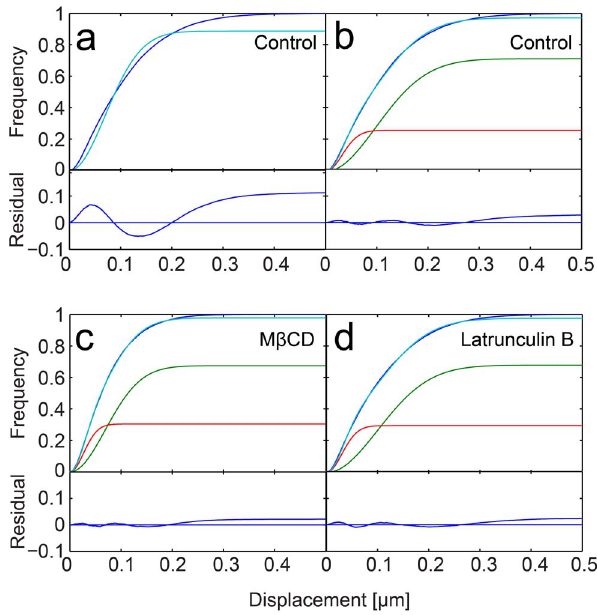
Figure 5. Cumulative histograms of jump distances of LPS- bound receptors in the plasma membrane (blueline). Best fits according to Eq. 7 are shown (cyan) . (a) The cyan line represents the fit result assuming one species is present. The residual shows a clear deviation from the data. (b) The same data fitted assuming two species are present (components of the fit are shown in green for the mobile and red for the immobile population). The residual shows no systematic deviation of the fit from the data. Note that the deviation of the fit from the histogram towards larger displacements is also found in our simulated data (Fig. S7 and Note S3 in File S1) and thus does not indicate a deviation of the data from Brownian motion. (c) M b CD treated and (d) latrunculin B treated macrophages fitted assuming two mobility populations. The values for the diffusion coefficients and fractions can be found in Table